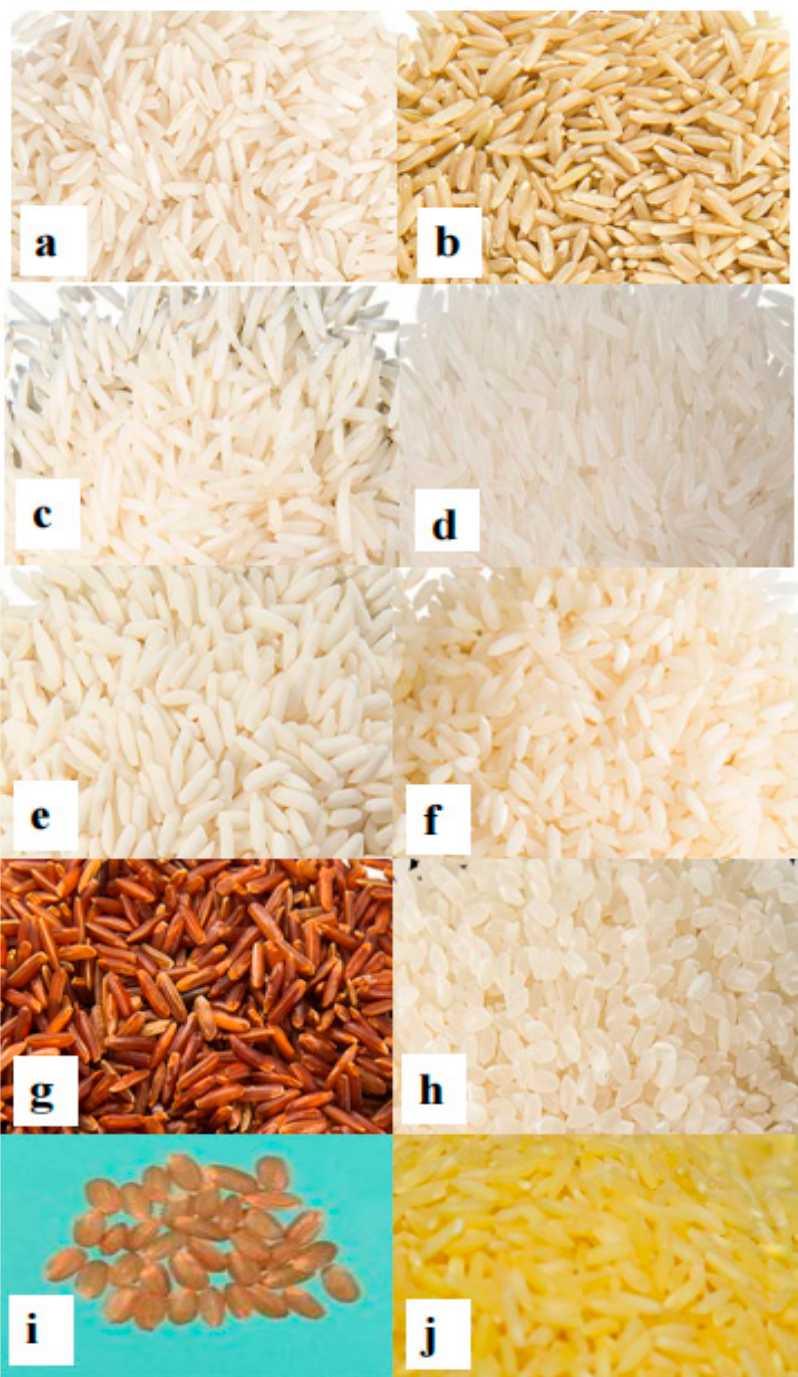
Figure 4. The various varieties of rice: ( a ) white rice, ( b ) brown rice, ( c ) basmati, ( d ) fragrant rice ( e ) glutinous rice, ( f ) ponni rice ( g ), red rice, ( h ), japonica rice, ( i ) weedy or red rice, and ( j ) golden rice [11,21].